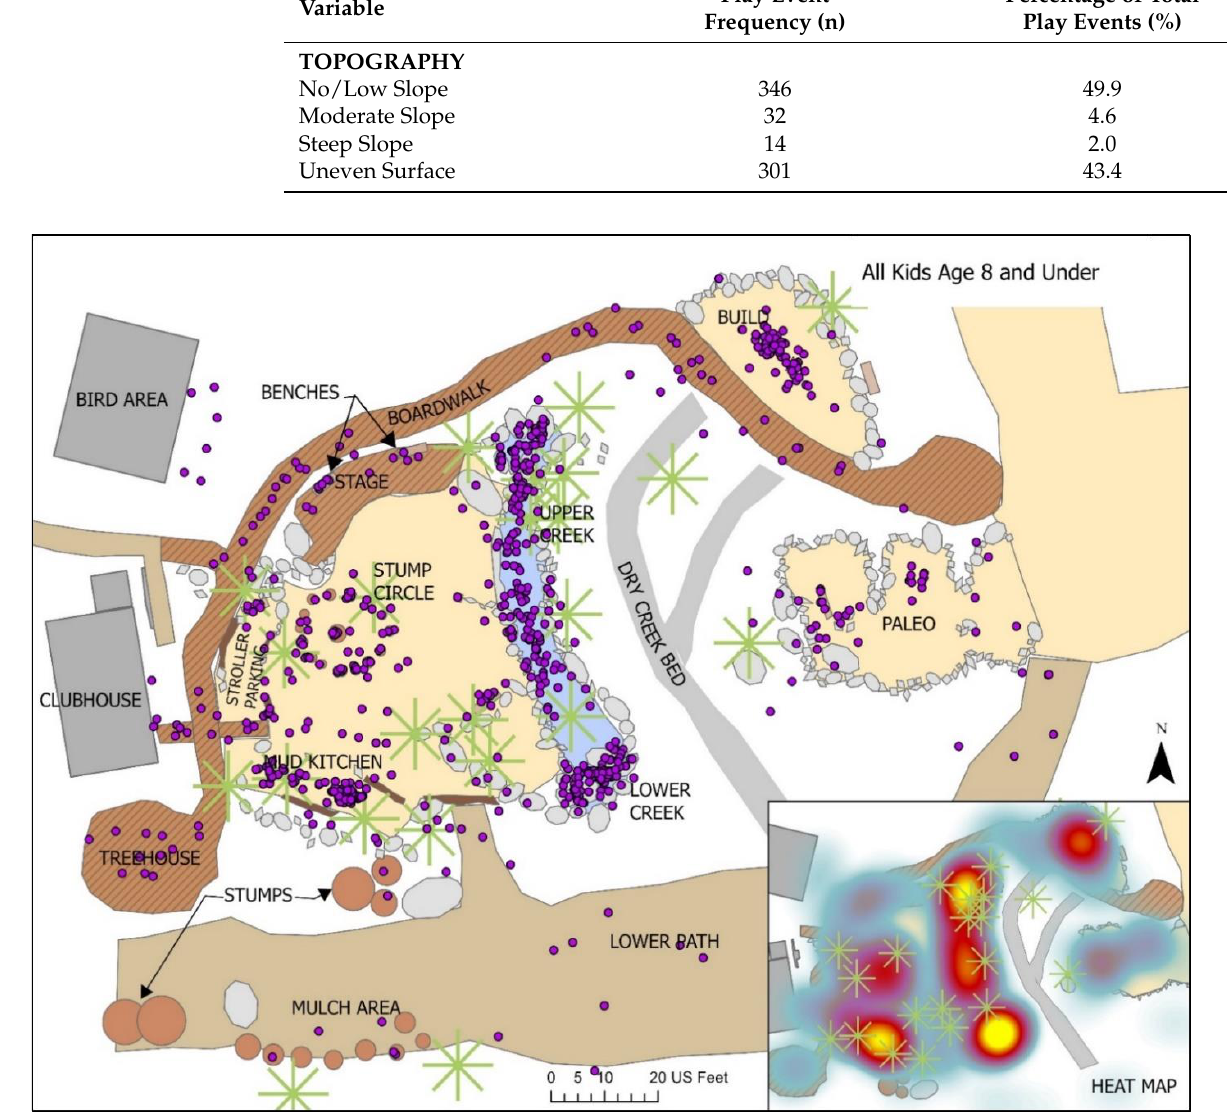
Figure 8. All observed play events for children 8 years and under.